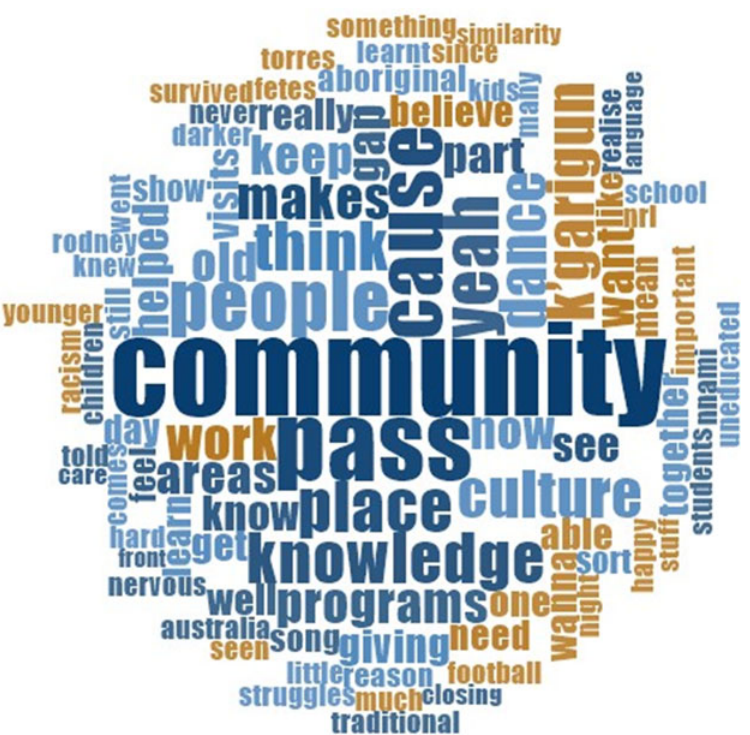
data coded into the future aspirations node (figure 4) demonstrate how the program impacted their plans for their future with the